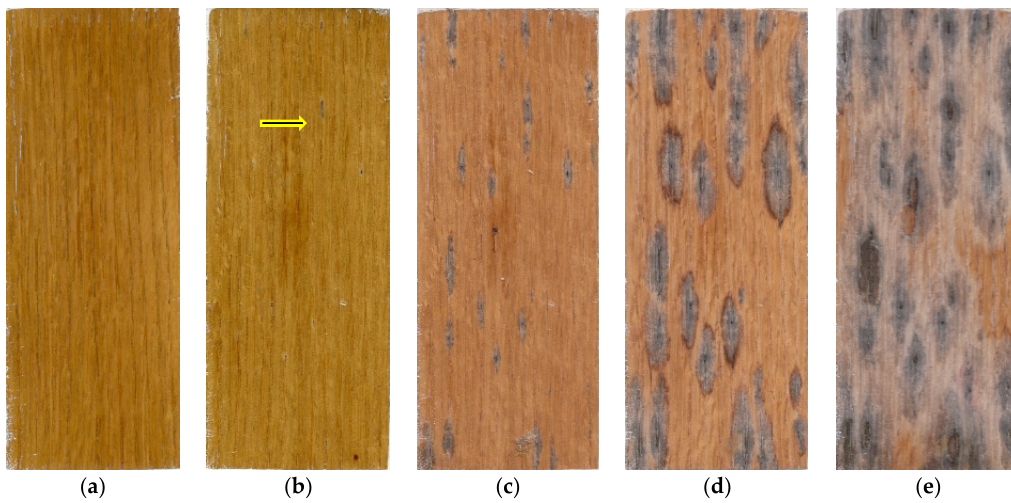
Figure 12. Appearance of a red oak panel treated with 30% PF resin and coated with a water-based spar urethane varnish before ( a ) and after exposure to the weather for ( b ) 1, ( c ) 2, ( d ) 3 and ( e ) 4 years.